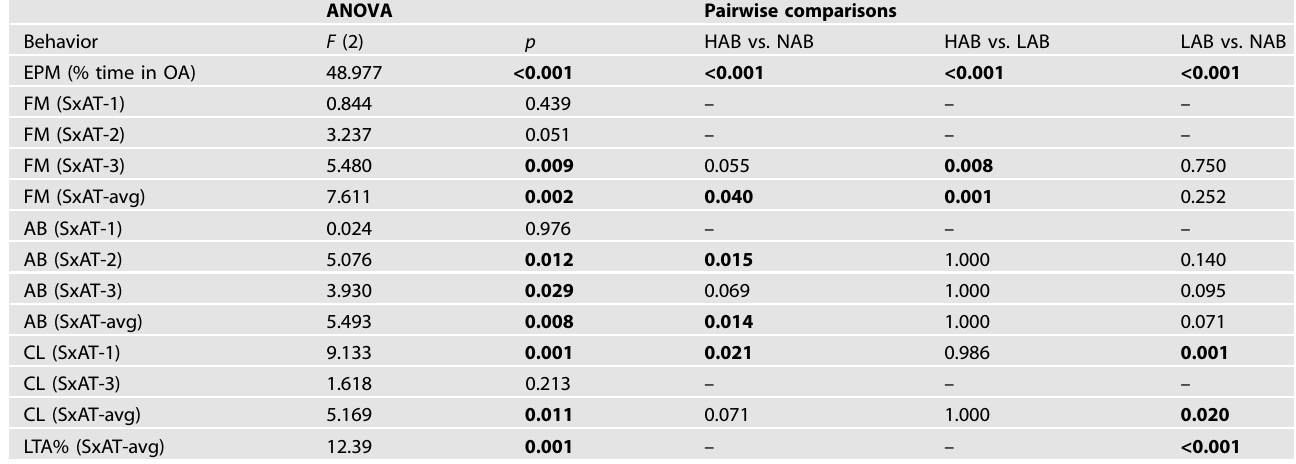
Table 2. Overview of ANOVA and, if appropriate, post-hoc pairwise comparisons between rats selectively bred for high (HAB) vs. low (LAB) anxiety behavior or not selectively bred (NAB) of their behaviors in a 5 min EPM or 5 min SxAT. ANOVA Pairwise comparisons